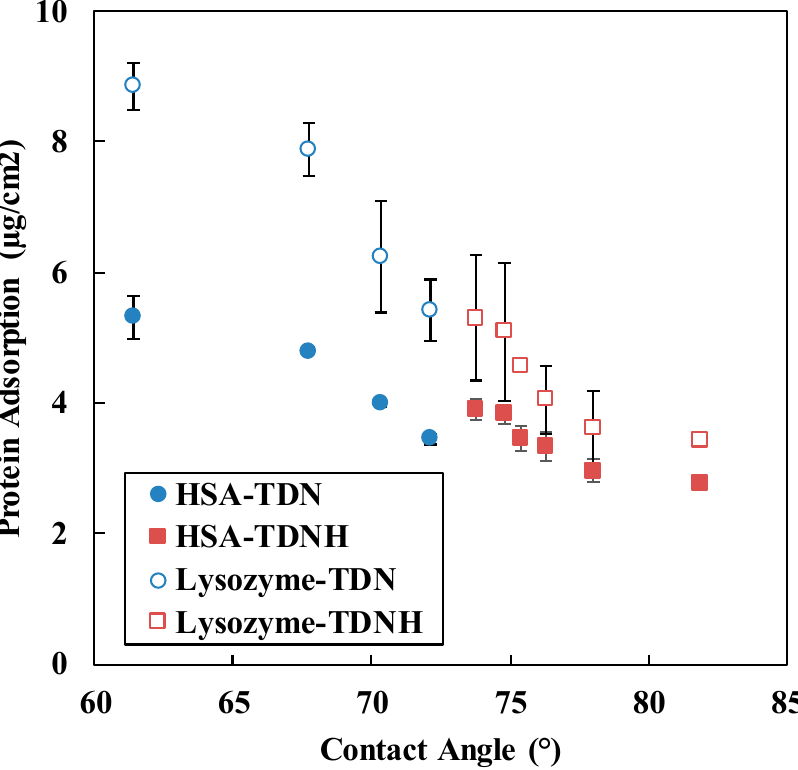
Figure 5. The e ff ect of contact angle on the adsorption of lysozyme and Figure 5. The effect of contact angle on the adsorption of lysozyme and HAS.